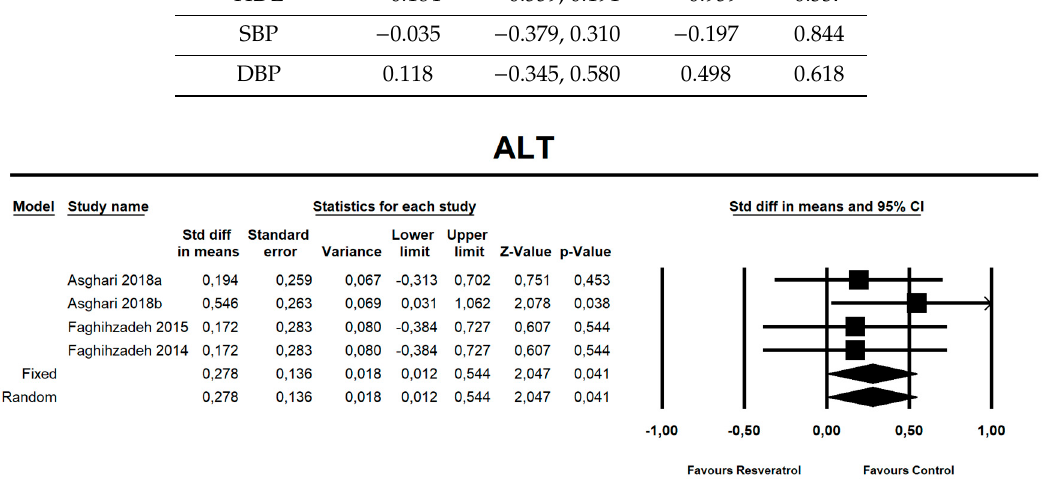
Figure 2. E ff ect size, standardized mean di ff erence, for ALT in persons taking RSV vs . controls (endpoint data). Q = 1.427, df(Q) = 3, p = 0.699, I -squared = 0.0. Figure 2. Effect size, standardized mean difference, for ALT in persons taking RSV vs . controls Egger’s tests showed no significant publication bias in the current meta-analysis (for all study (endpoint data). Q = 1.427, df(Q) = 3, p = 0.699, I -squared = 0.0. outcomes p > 0.05; Figures